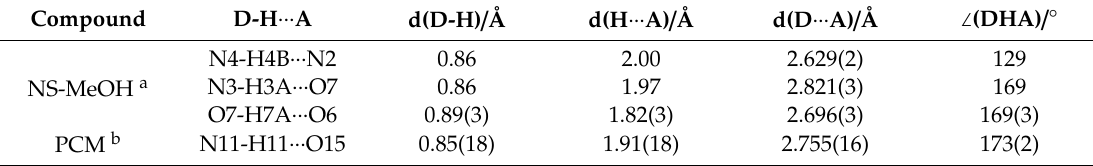
Table 2. Hydrogen bonds of NS-MeOH and